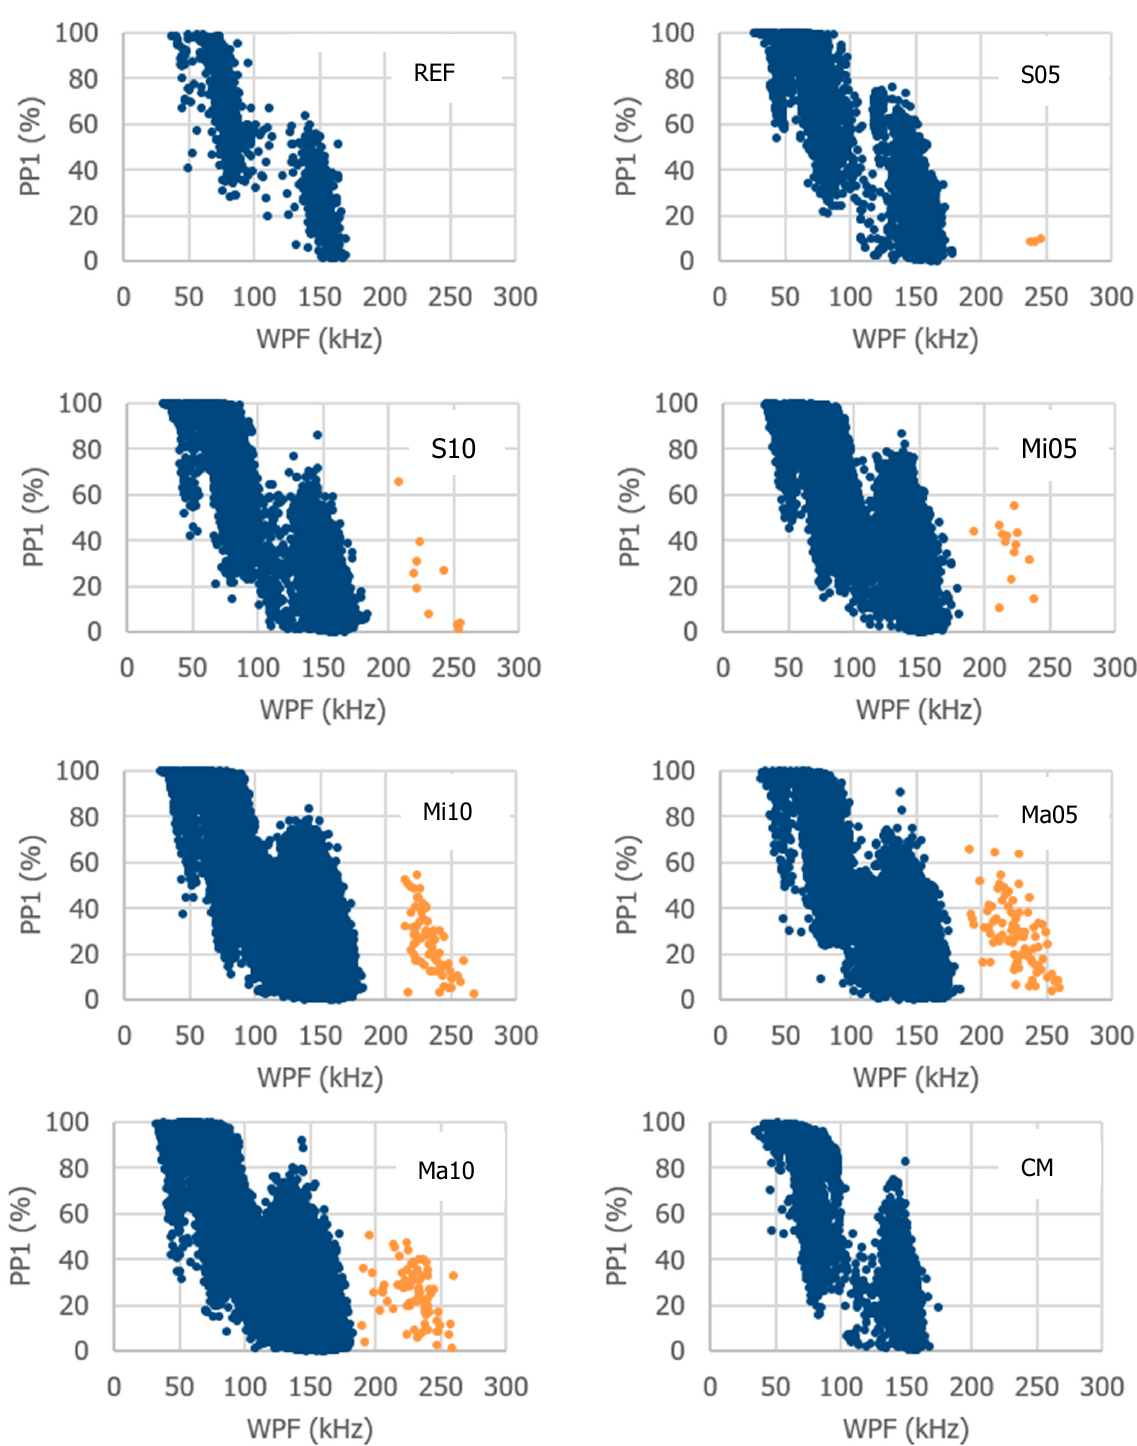
Figure 7. Clustering of AE activities as matrix cracking and fiber activities based on WPF vs. PP1 parameters ( ● Cluster-1, ● Cluster-2).